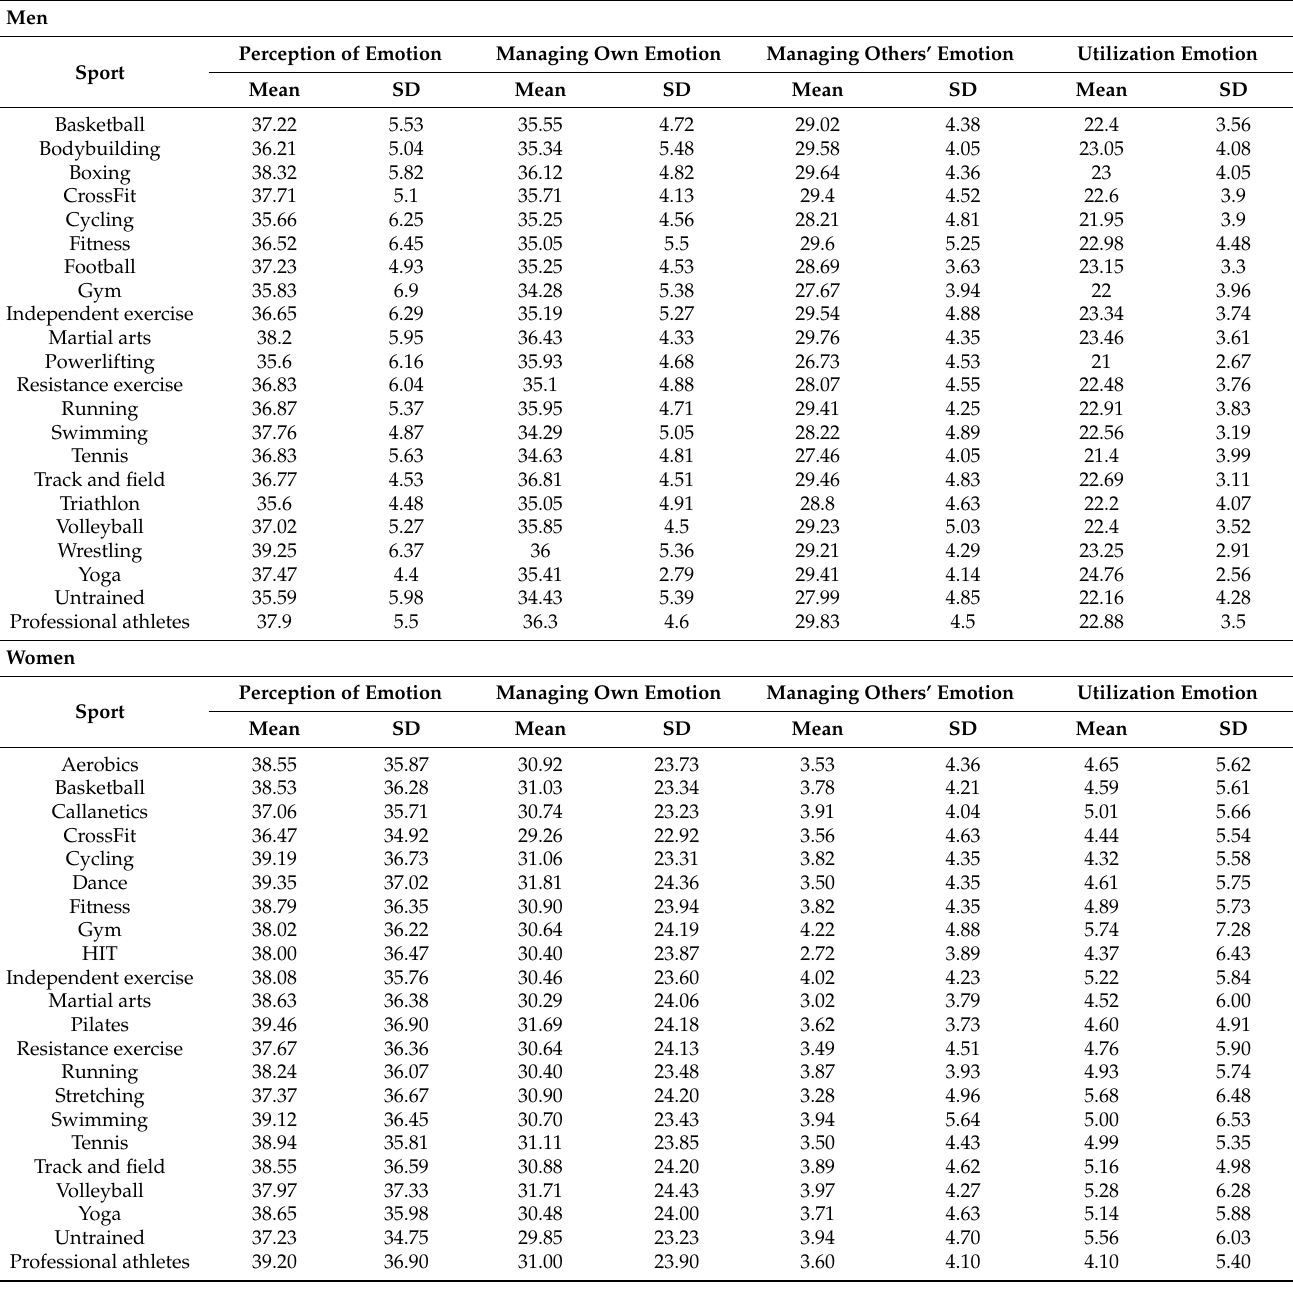
Table 5. Relationship between different components of emotional intelligence and type of exercise in men and